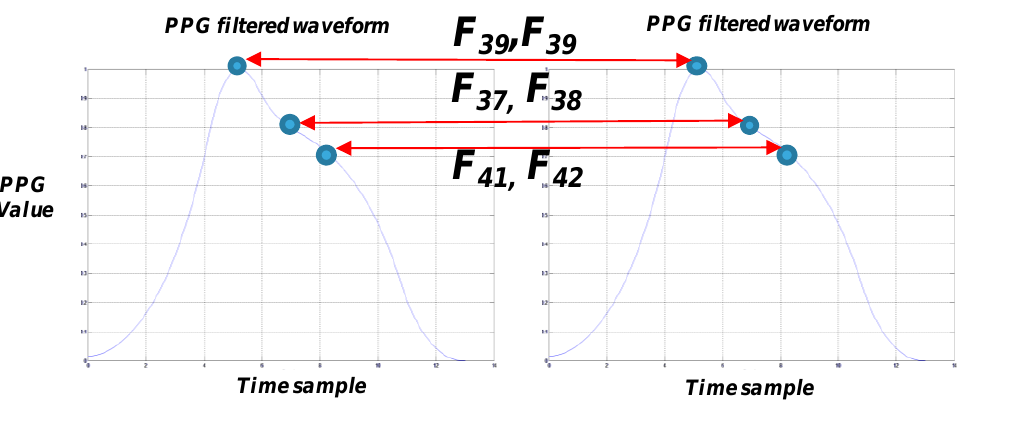
Figure 6. Detailed description of the variables used for hand-crafted features F 37 – F 42 .